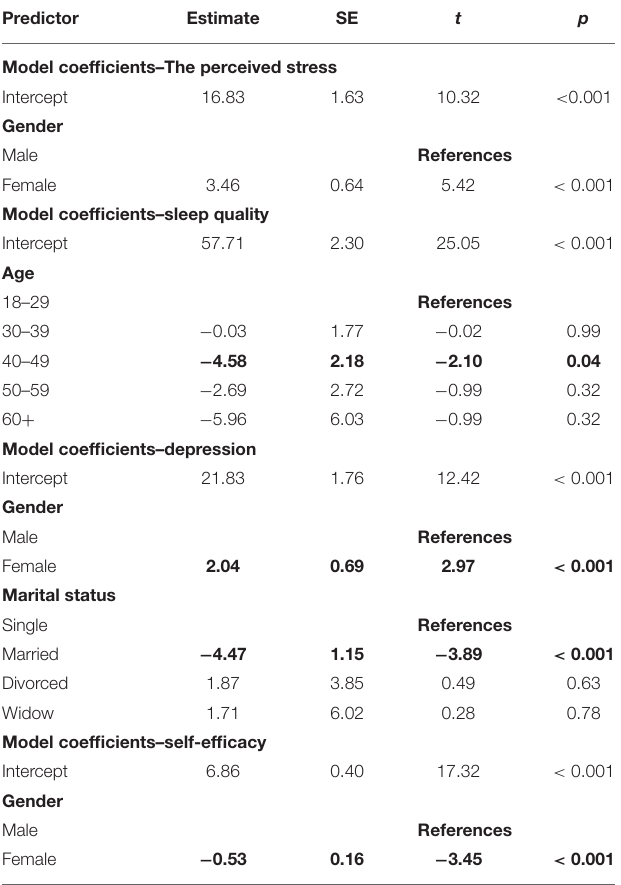
TABLE 5 | Association of socio-demographic variables with stress, sleep quality, depression, and self-efficacy based on the multivariate regression analysis.